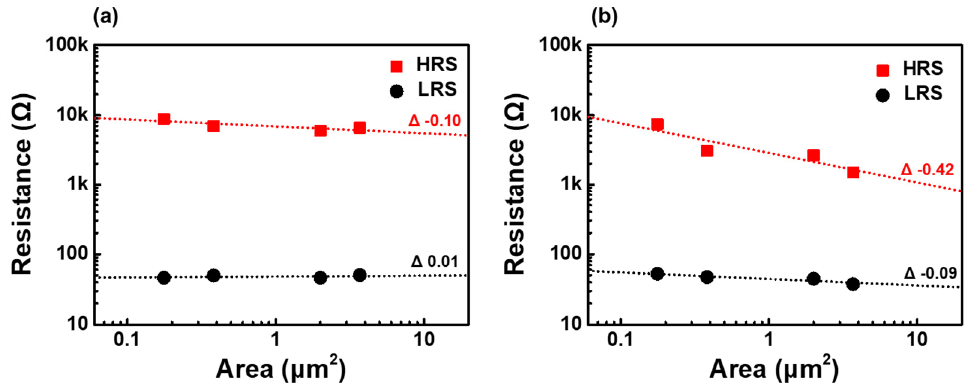
Figure 4. Area dependence of HRS and LRS resistances for Pt/Ni 1 − x O/TiN stacks ( a ) with Ni 1 − x O films, deposited with oxygen partial pressure fraction of 10%, with electroforming ( b ) with Ni 1 − x O films that are deposited with oxygen partial pressure fraction of 50%, with reset-first BRS without electroforming.